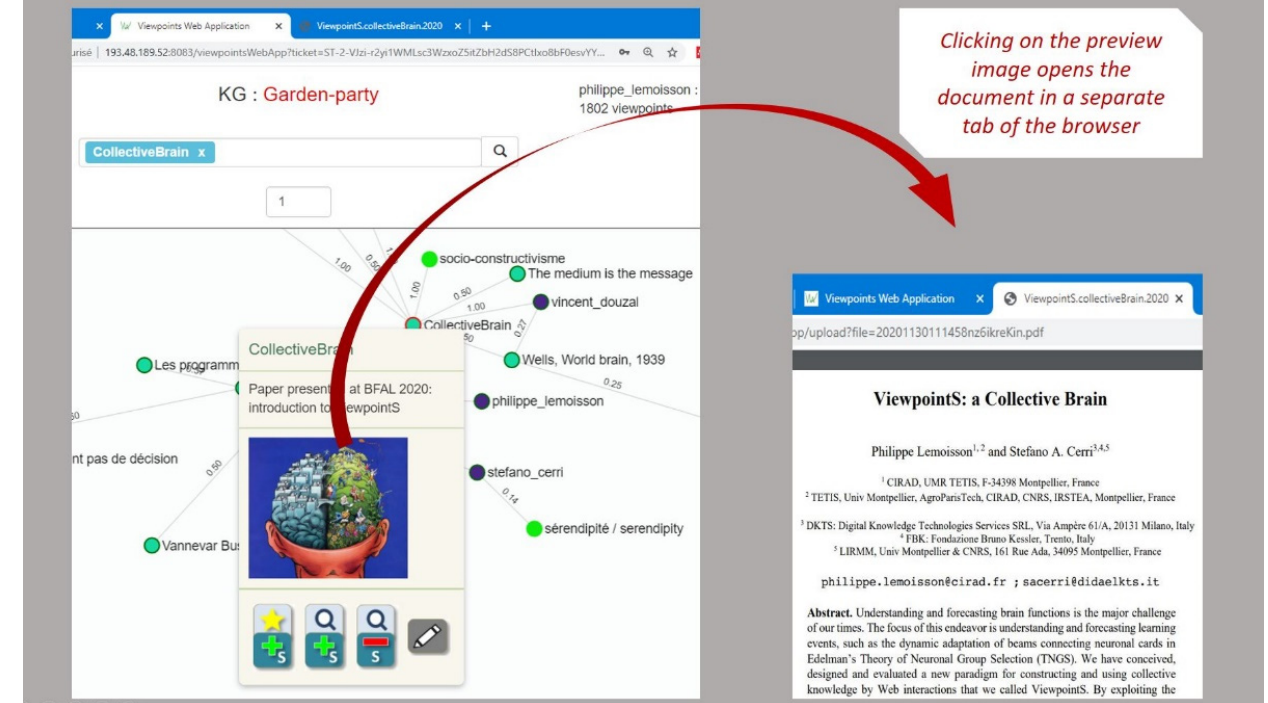
Figure 3. How the community members read in the medium: preview before access.